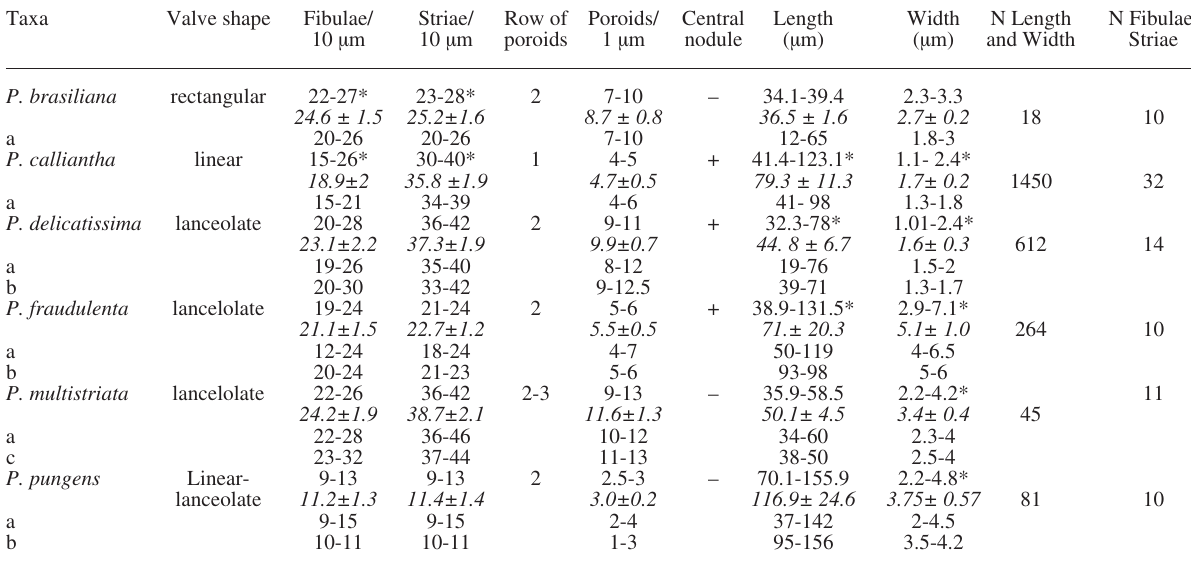
Table 1. – representative morphological characteristics observed for nW mediterranean Pseudo-nitzschia species from field samples com- pared with literature data. a hasle (1995), priisholm et al (2002), Lundholm et al (2003). b Kaczmarska et al (2005), c orsini et al (2002) number in italic show mean ± Sd. all measurements were made with Sem. n= number of observation. *differences from description